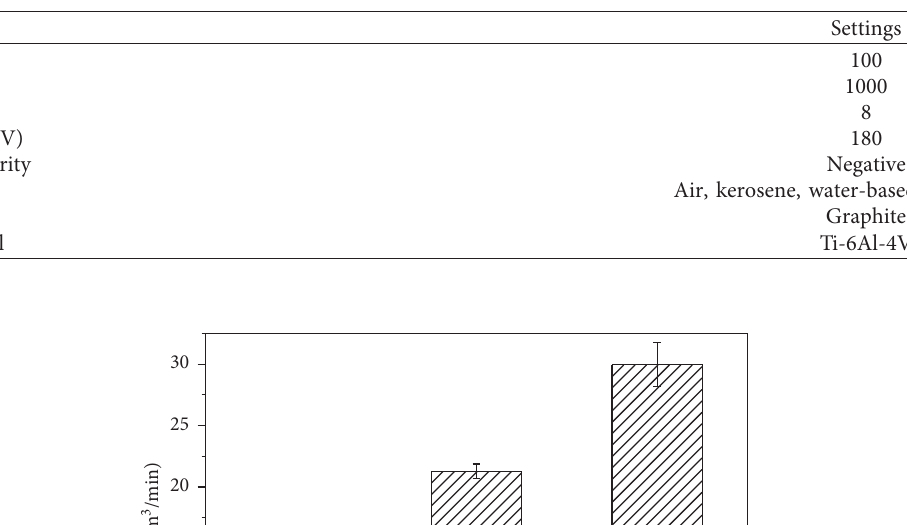
Table 1: Process parameters for working medium tests.